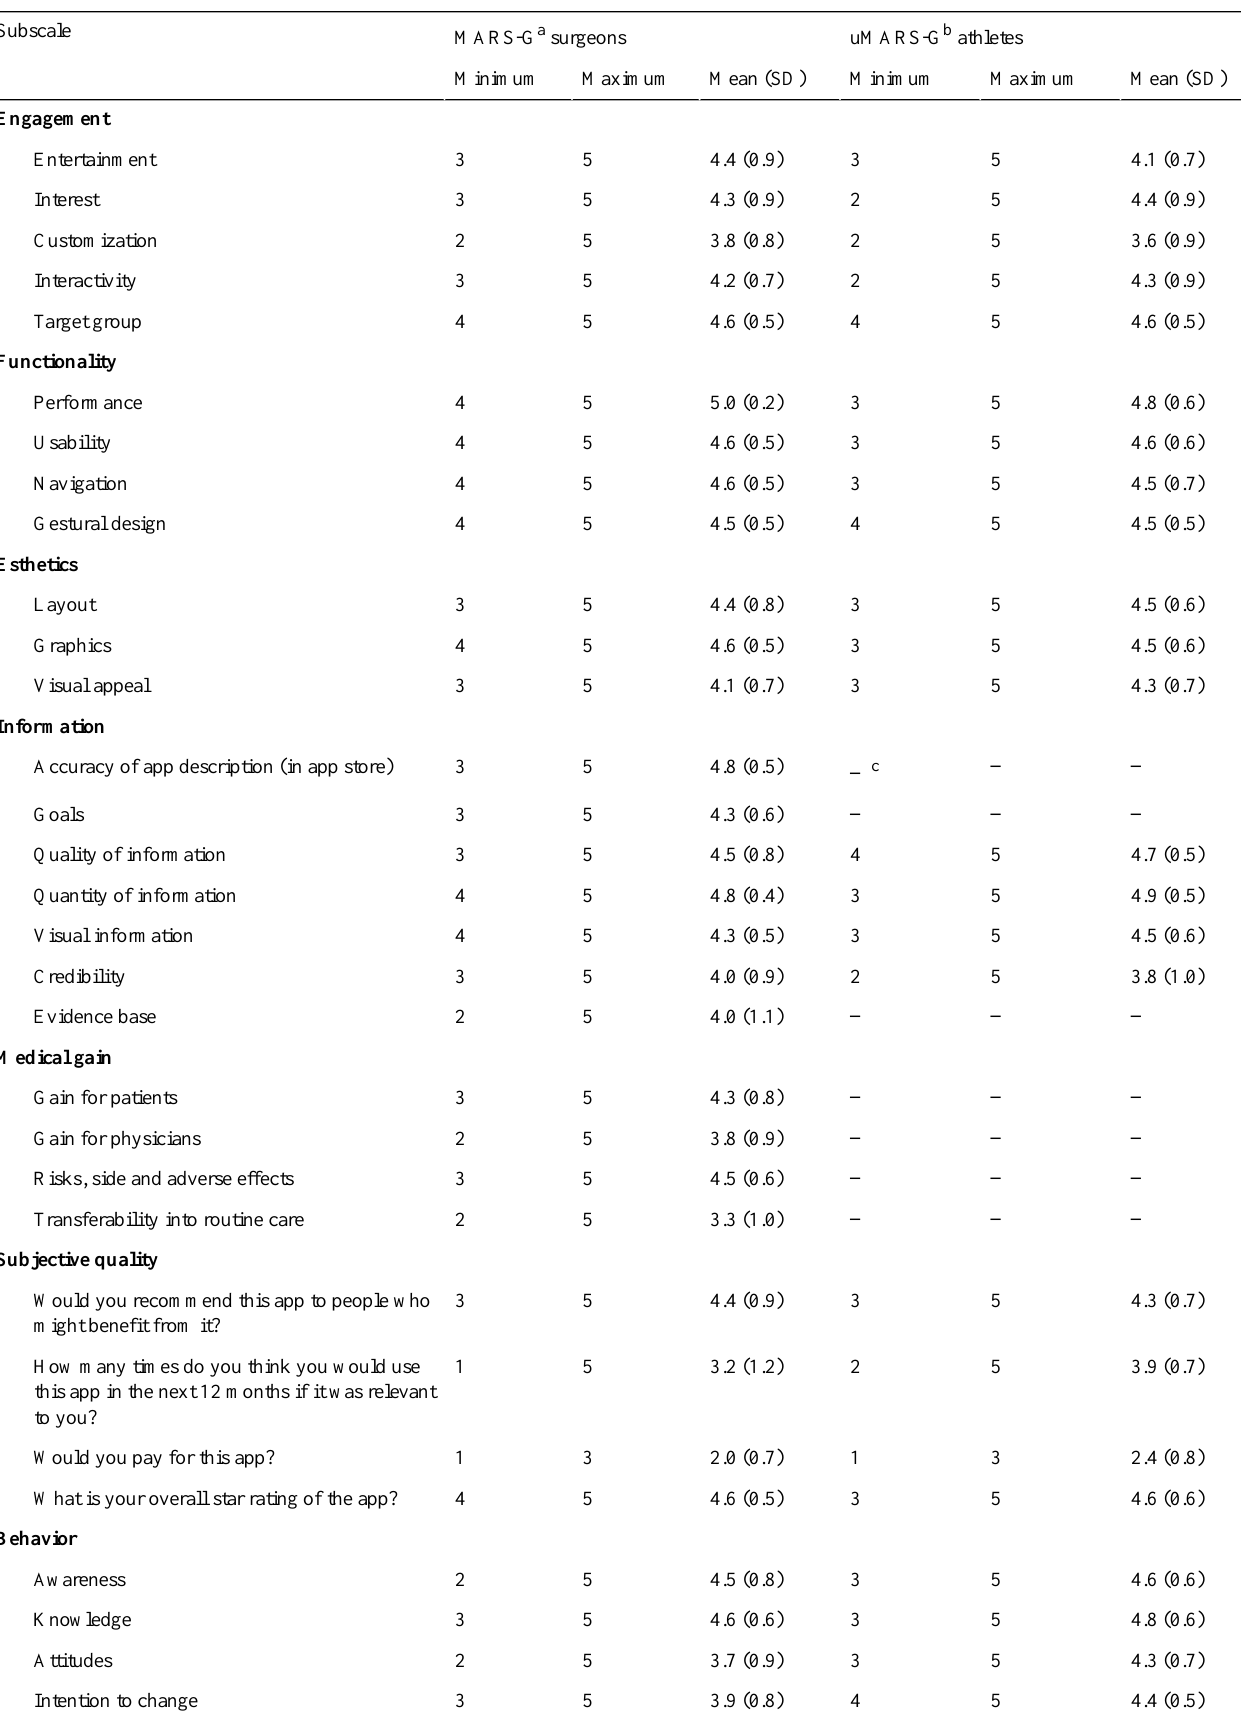
Table 1. Detailed results of the (user) German Mobile App Rating